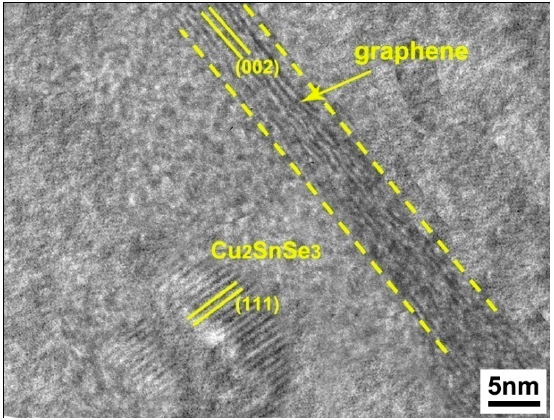
Figure 6. High-resolution TEM (HRTEM) image of graphene nanosheets in the graphene/Cu 2 SnSe 3 sample.